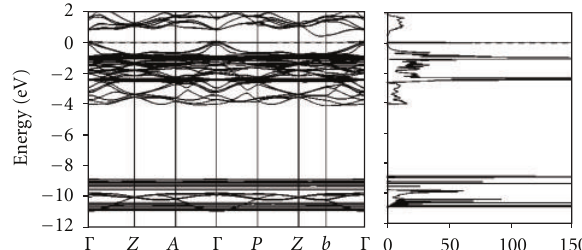
Figure 77: Self-consistent LSDA+ U energy band structure and total DOS (per unit cell and eV) of Yb 4 As 3 [423] ( U (2+) 8 . 8eV).